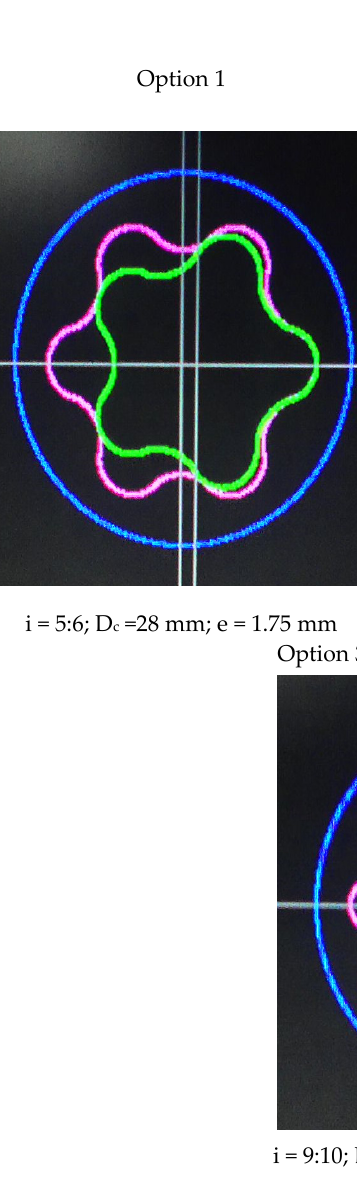
Figure 4. Sections of three PS variants with different kinematic ratios. Table 2. Geometrical parameters of the power section with kinematic ratios of 5:6, 7:8, and 9:10